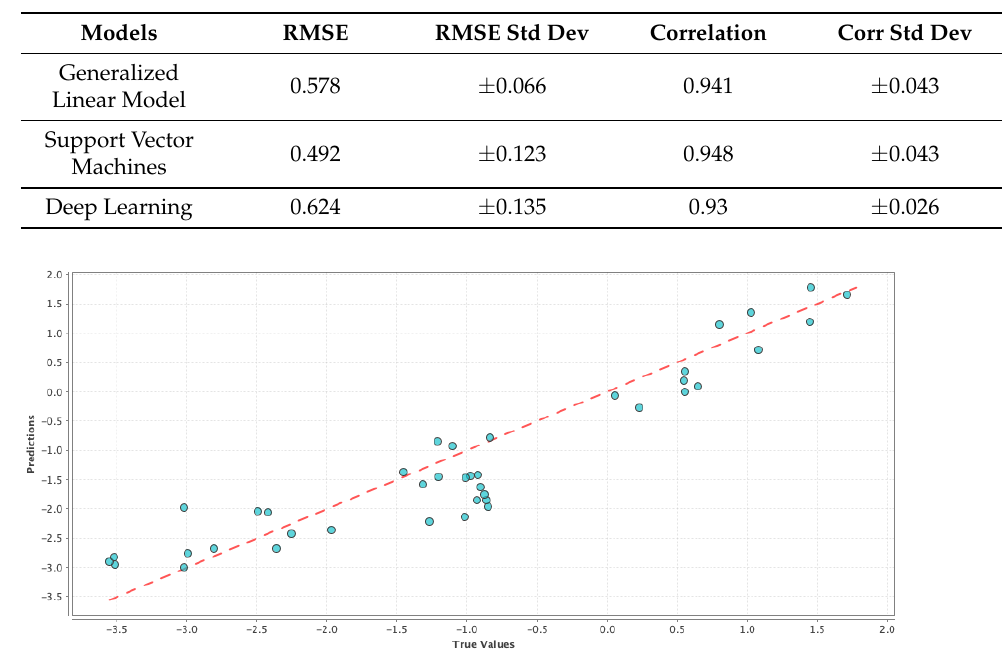
Figure 4. Result on Test Set For Generalized Linear Model using Model 6 from Table 3. The x-axis represents the true or the actual PDSI values and the y-axis represents the predicted PDSI values. Each small blue circle in the figures is represented by the tuple ( PDSI actual , PDSI pred ). The red dashed line is the reference line to test the model performance.